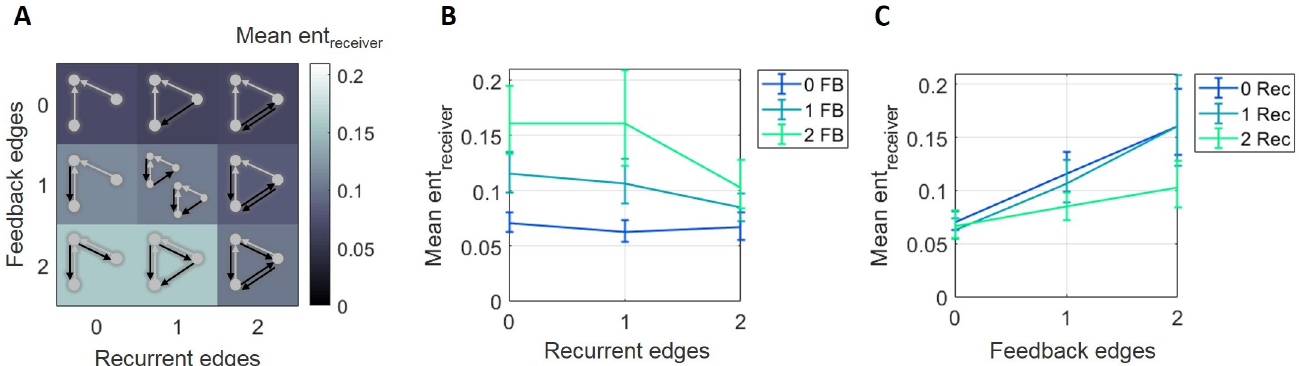
Fig 6. Receiver entropy decreased with greater recurrence and increased with greater feedback. (A) Mean receiver entropy decreased with the number of recurrent edges and increased with the number of feedback edges in motifs. (B) Curves representing rows shown in A, plotted with errorbars computed across networks, show that receiver entropy decreased as the number of recurrent edges increased. (C) Curves representing columns shown in A, plotted with errorbars computed across networks, show that receiver entropy increased as the number of feedback edges increased. Errorbars are 95% bootstrap confidence intervals around the